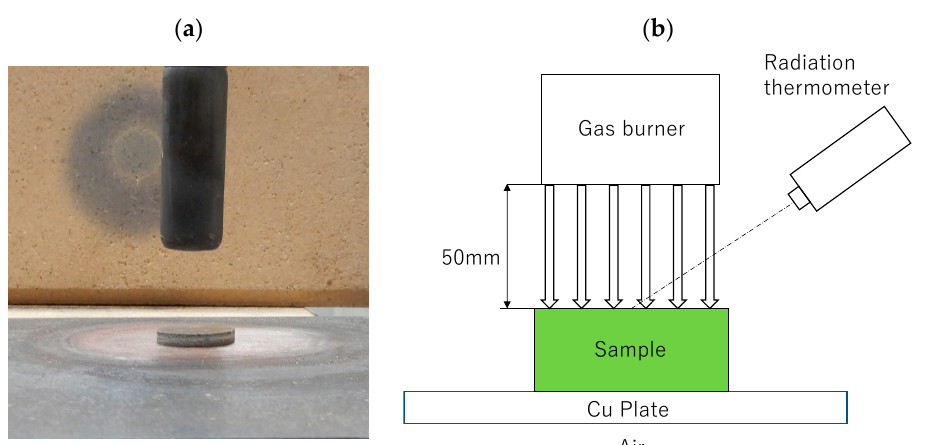
Figure 6. Cyclic thermal shock test set-ups. ( a ) photo and ( b ) illustration.